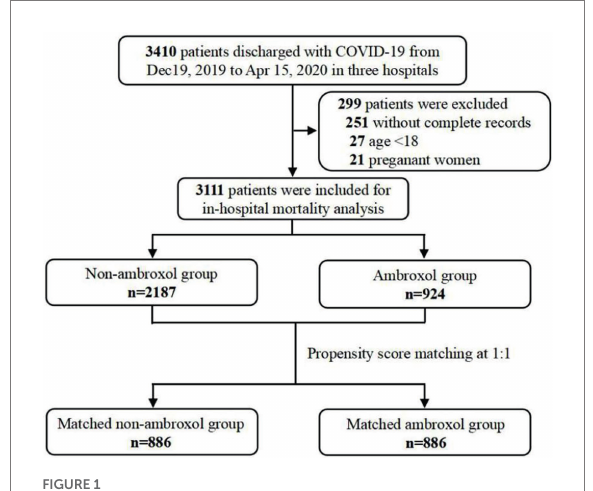
FIGURE 1 Sampling strategy of COVID-19 admissions in